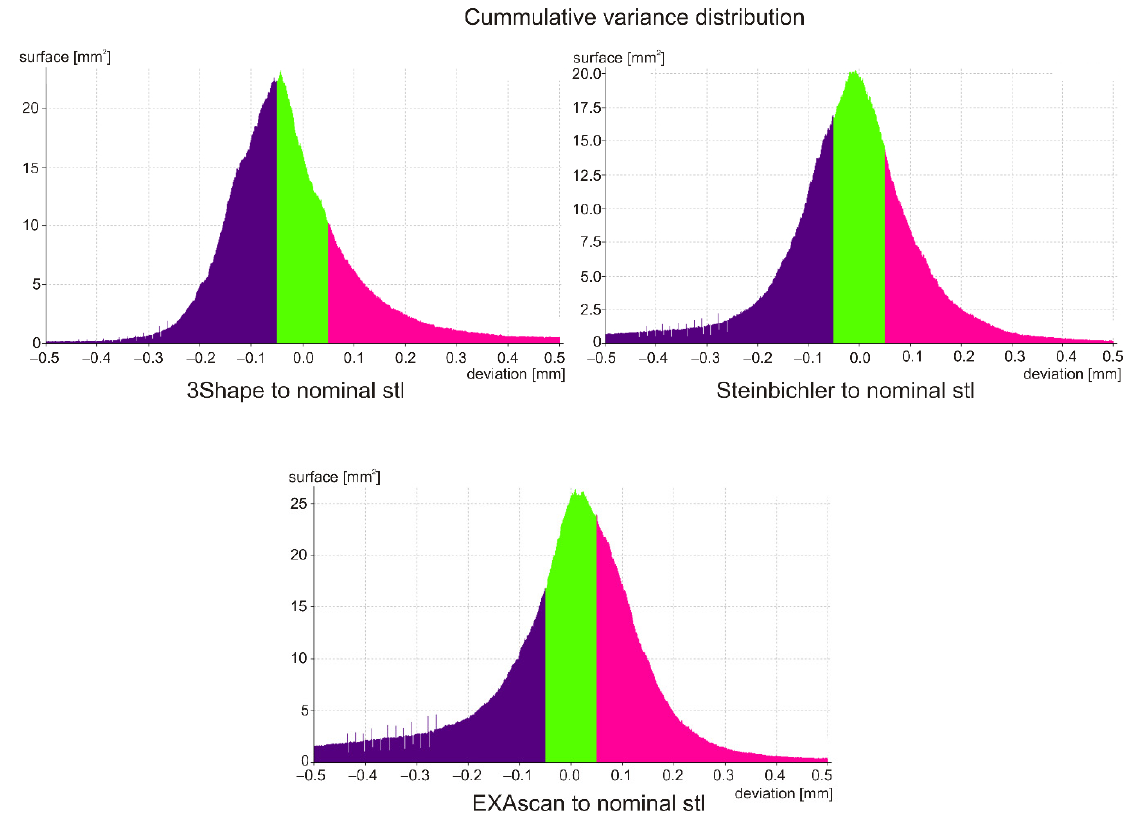
Figure 8. Histogram of the distribution of deviations.